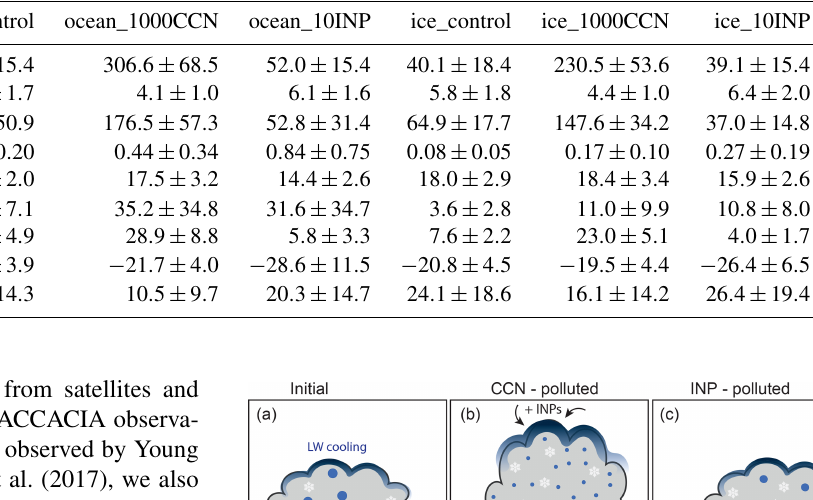
Table 3. Averaged cloud properties ± 1 standard deviation throughout the simulated time period following the aerosol injection (hour 2–20) for the unperturbed and perturbed simulations. Note that for net surface SW radiation we only averaged over daytime (8.5h in total).